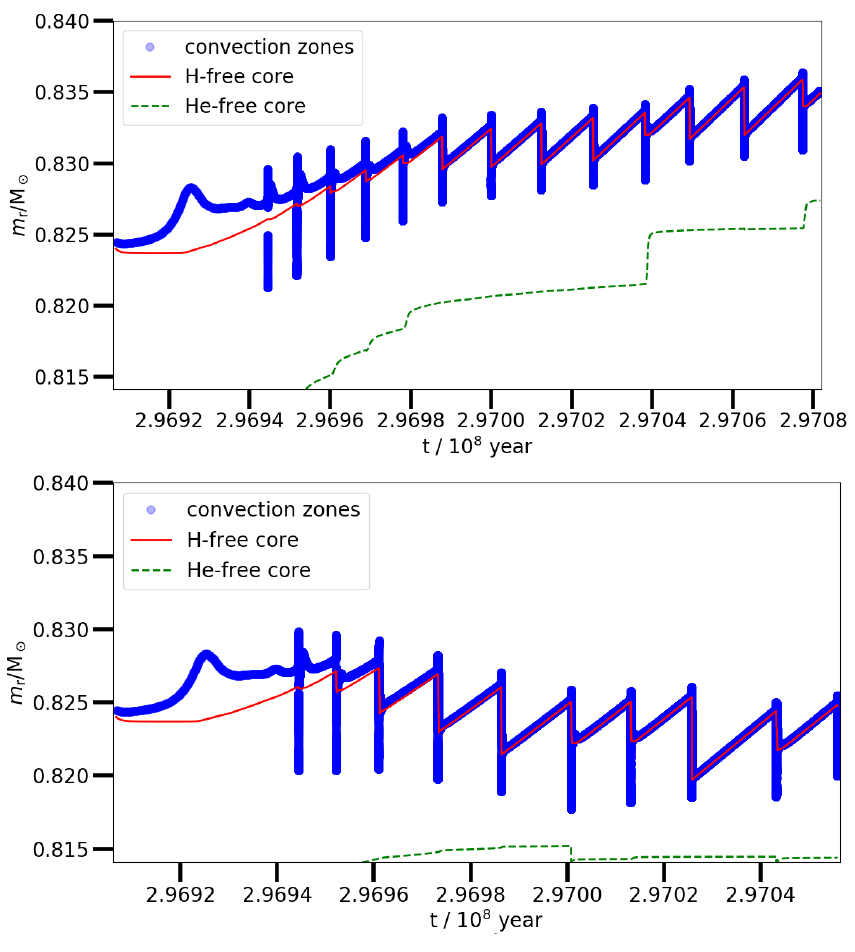
Figure 1. Upper panel : Kippenhahn diagram of m3z1m3-nofTP zoomed in the He-intershell. Lower panel: same as in the upper panels, but for m3z1m3.